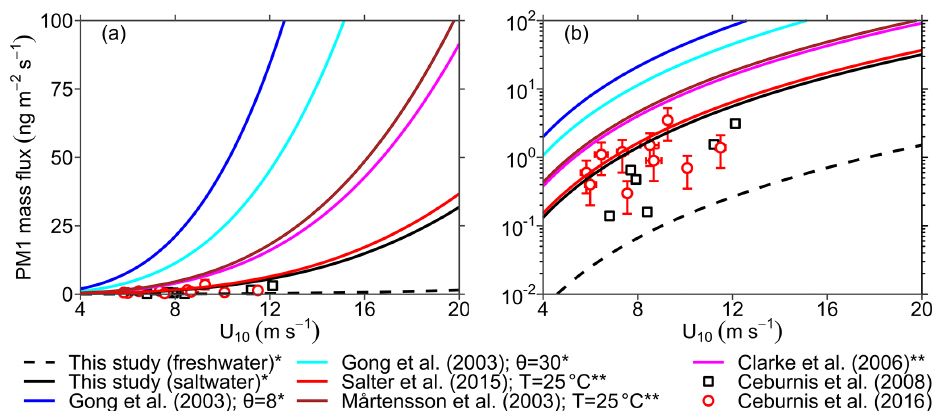
Figure 5. The calculated mass fluxes from the source functions shown in Fig. 4b compared with PM 1 mass flux measurements from Ceburnis et al. (2008, 2016) on a (a) linear and (b) logarithmic y axis. ∗ Computed using Eq. (9). ∗∗ Computed using Eq.